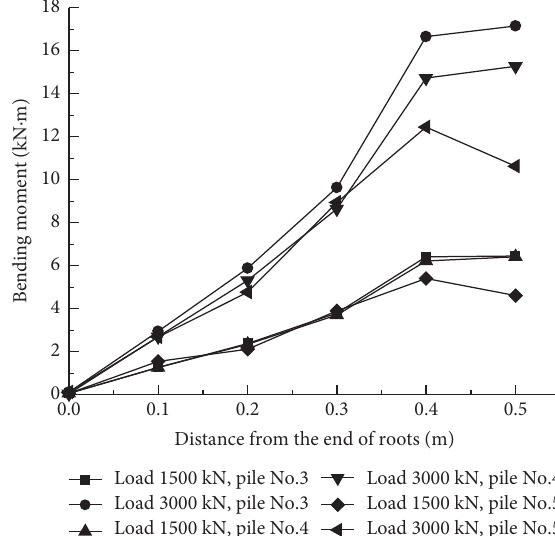
Figure 9: Bending moments of the root cross